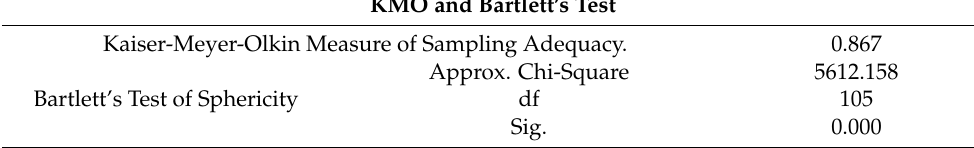
Table 2. KMO and Bartlett’s test. A KMO value greater than 0.8 indicates the presence of a strong partial correlation among the features and the number for the significance of Bartlett’s test is less than 0.05.